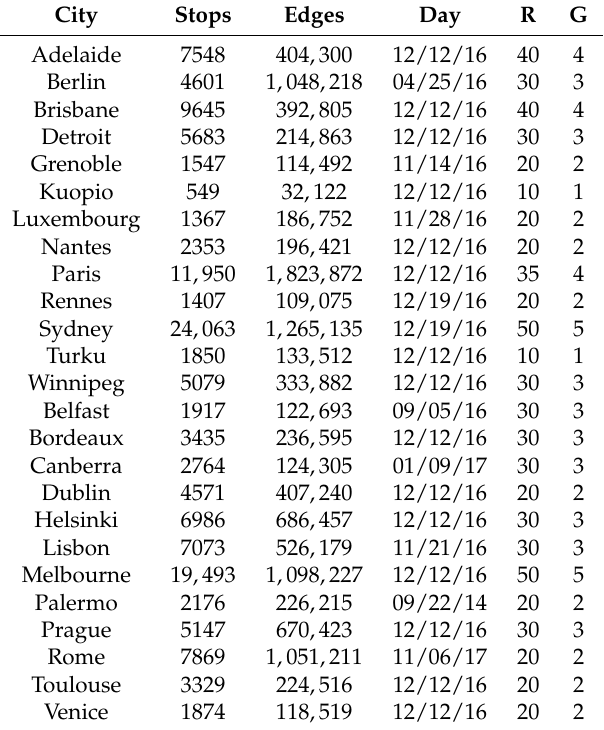
Table 6. The 25 cities included in the public transport network dataset [14]. The Stops column indicates the number of nodes, the Edges column the number of temporal edges, the Day column the day in which the data were collected, the R column the city’s radius (in km), and the G column the group the city belongs to. City Stops